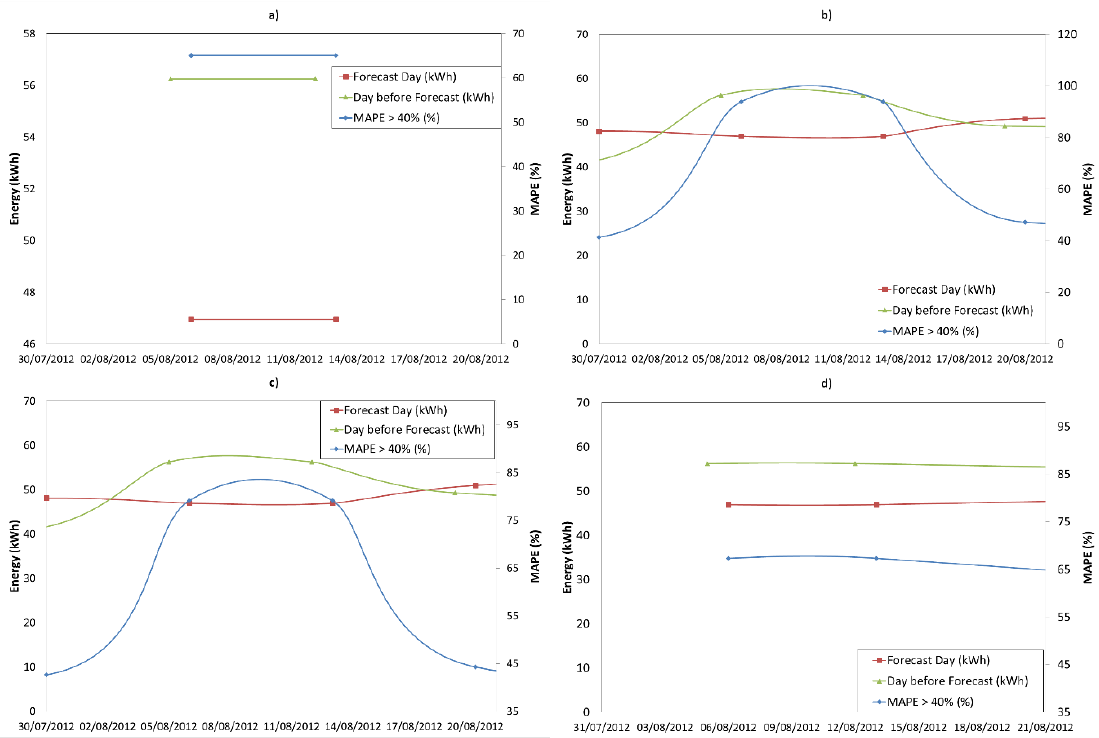
Figure 9. MAPE (%) (1) over 40%, 3–20 August 2012 . Mondays: ( a ) F_L ; ( b ) F_L_W ;